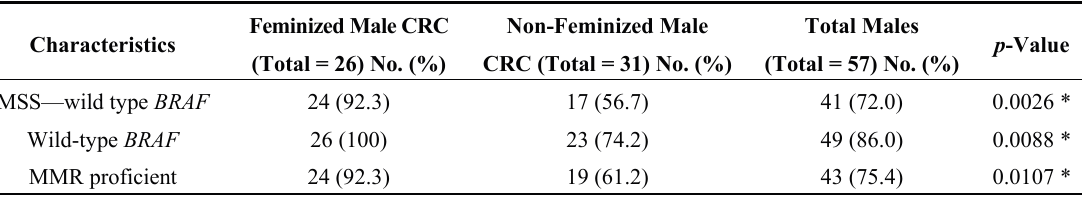
Table 4. Clinicopathological characteristics of feminized colorectal cancers in male